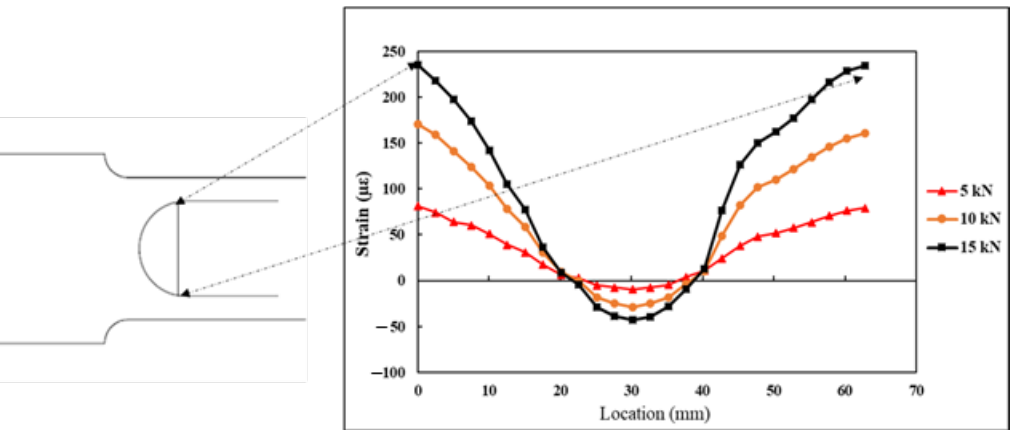
Figure 16. Strains measured by the DFOS under tensile load.